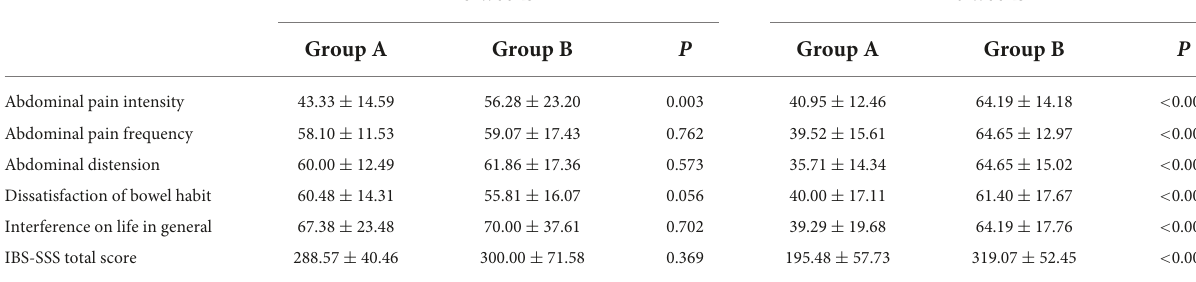
TABLE 3 Comparison of IBS symptom between the two study